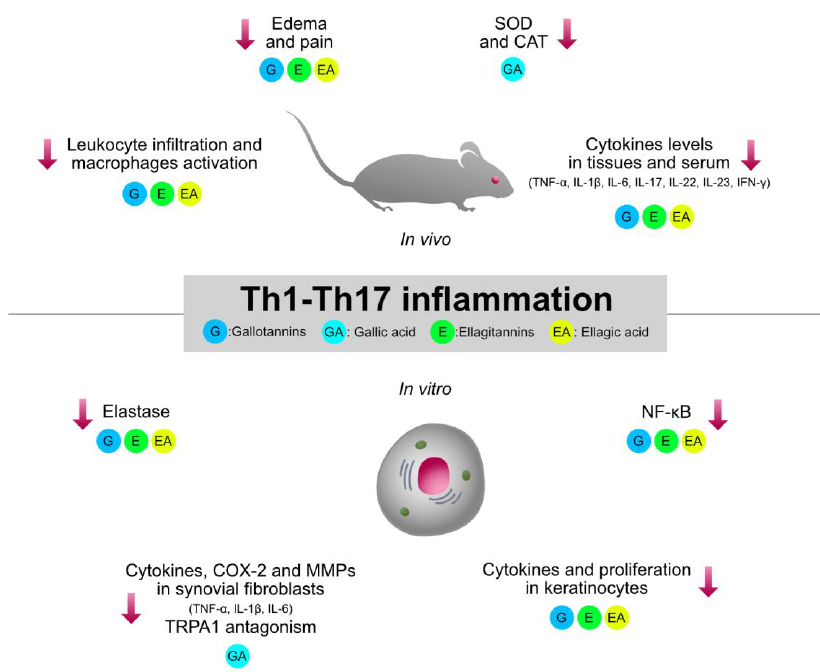
Figure 3. Graphical summary of the anti-inflammatory mechanisms of HTs and their hydrolysis derivatives (GA, EA), investigated in type 1 inflammation models (RA, IBDs, psoriasis). The com- pounds share immunosuppressive properties on innate cytokines (TNF- α , IL-1 β , IL-6) and type 1 cytokines (IL-23, IL-17, IFN- γ ), which are modulated by NF- κ B and STAT pathways. G, gallotannins; E, ellagitannins; GA, gallic acid; EA, ellagic acid. Red arrows indicate inhibition.